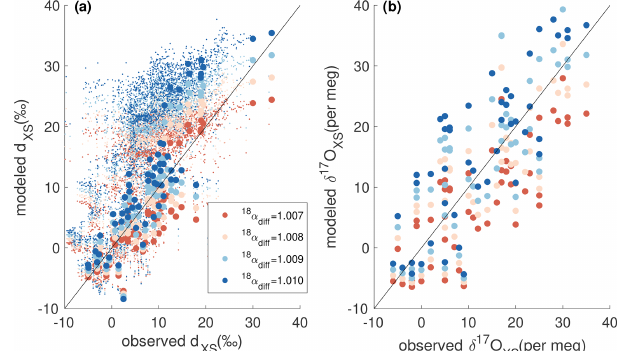
Figure A6. Relationship between observed and model d xs (a) and 17 O xs (b) of vapor over the Southern Ocean. Observed vapor val- ues are from Uemura et al. (2008, 2010) (large dots) and Liu et al. (2014) (small dots). Modeled values use the reported T 0 , SST 0 , and RH 0 from the observations and four different values of 18 α diff (shown in color of dots). The 1 : 1 line is shown in